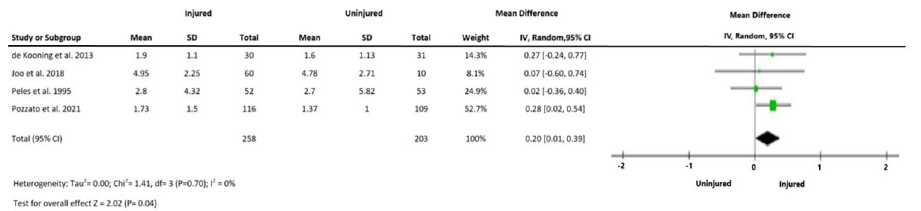
Fig 4. Outcome 3: Difference in LF: HF ratio between injured and uninjured